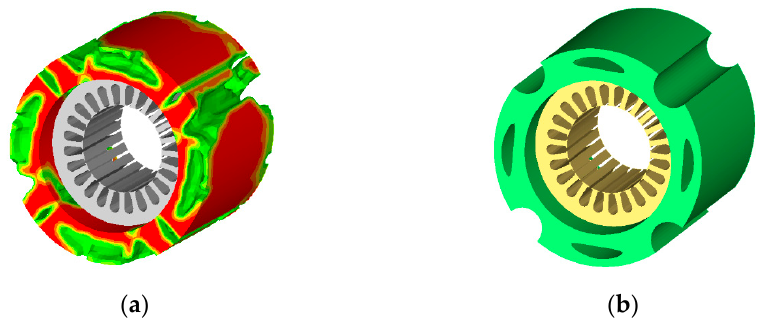
Figure 10. Result of Topology optimization: Circular shape housing design ( a ) Topology optimization result of element density ( b ) Redesign model.